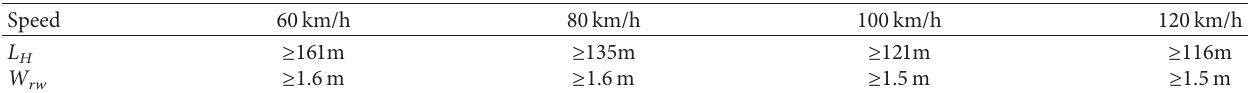
Table 4: Water length and width threshold of lateral